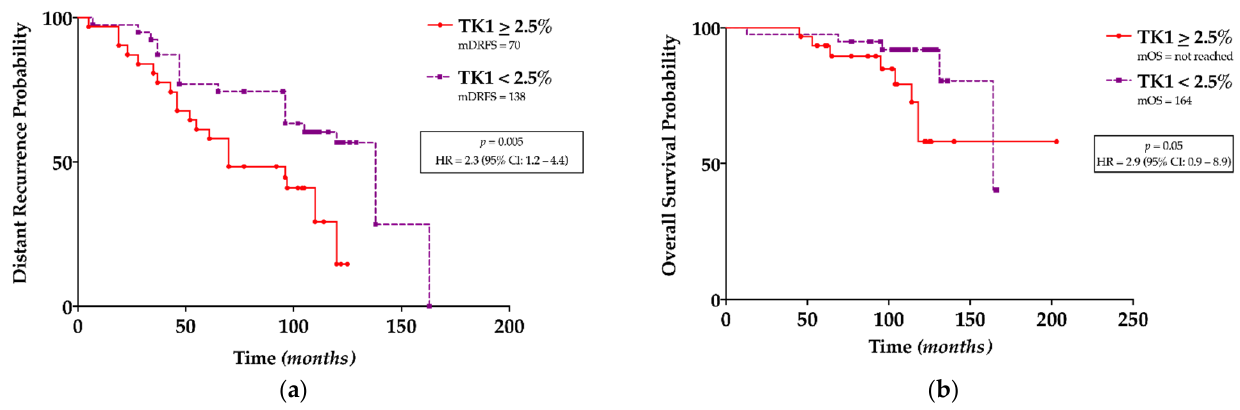
Figure 3. Survival analyses: ( a ) in the cohort undergoing adjuvant chemotherapy, patients with TK1 positive BC ( ≥ 2.5%) have a shorter DRFS (mDRFS: 70 vs. 138 months; HR = 2.3, 95% CI 1.2–4.4; p = 0.005), ( b ) but not a shorter OS.